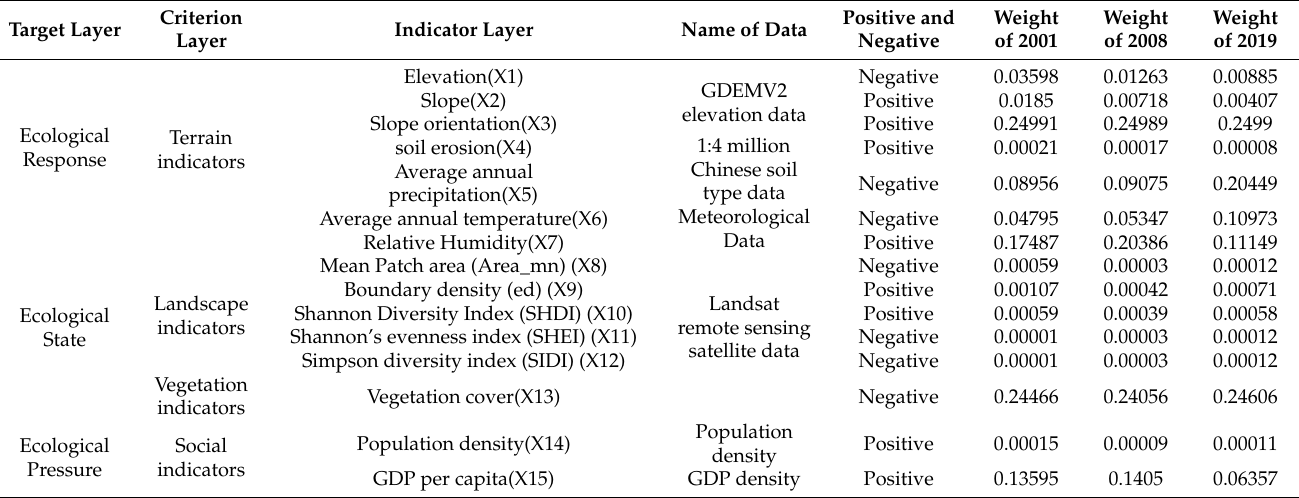
Table A2. Data sources and evaluation